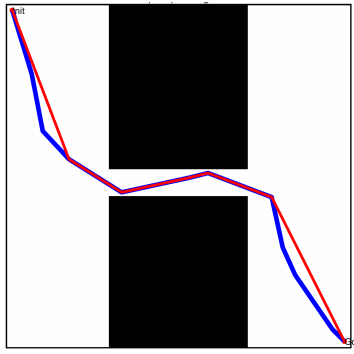
Figure 20. Path obtained by the optimized path pruning